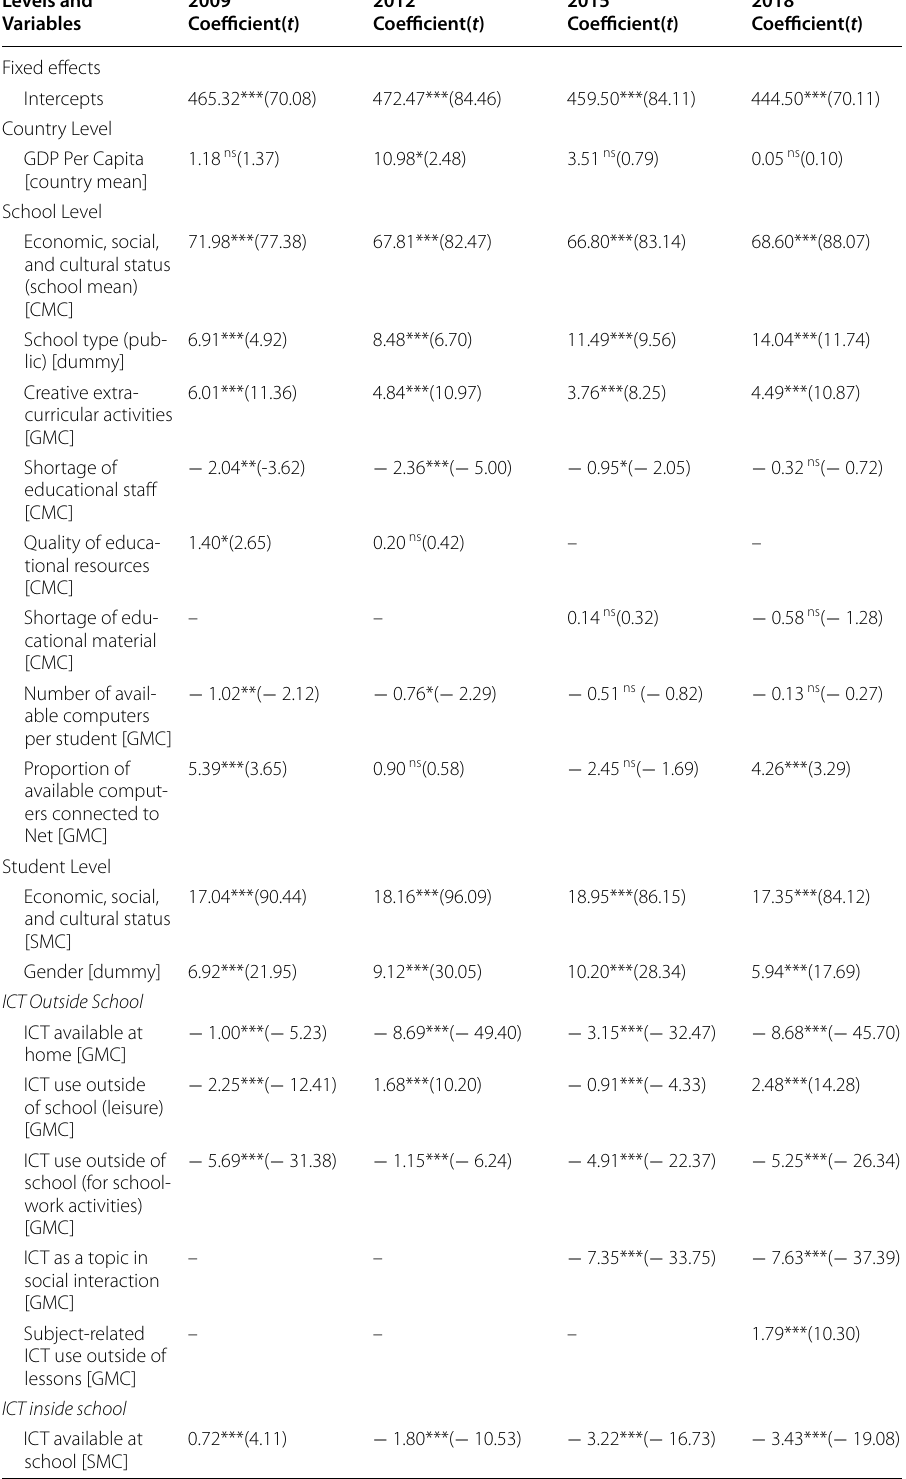
Table 4 Mixed Effects Model for Students’ Science Ability Levels and